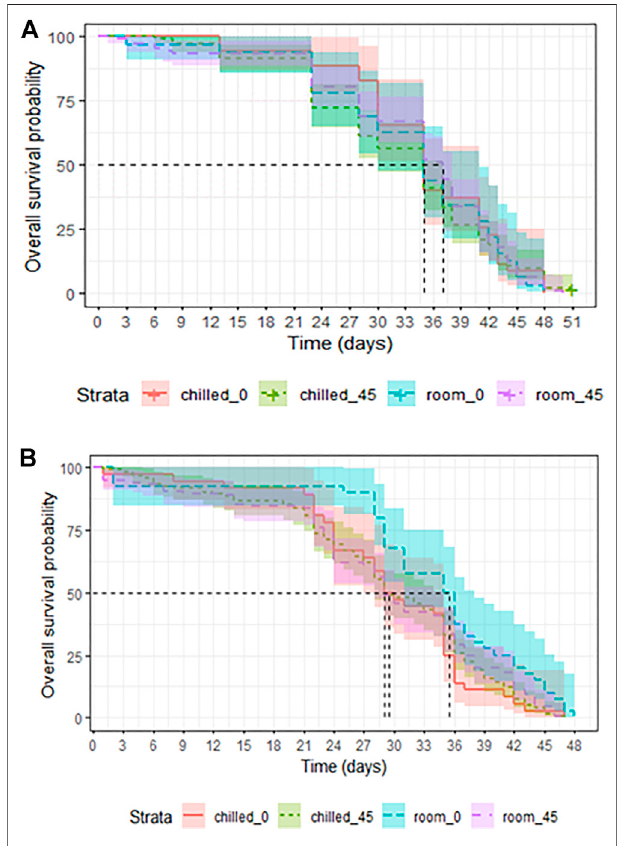
FIGURE 6 | Egg hatch rates of Aedes albopictus males irradiated at 45Gy in normoxia (O 2 ) vs. anoxia (N 2 ). The boxplot shows the median, and upper and lower quartiles. The dots indicate the values obtained for each